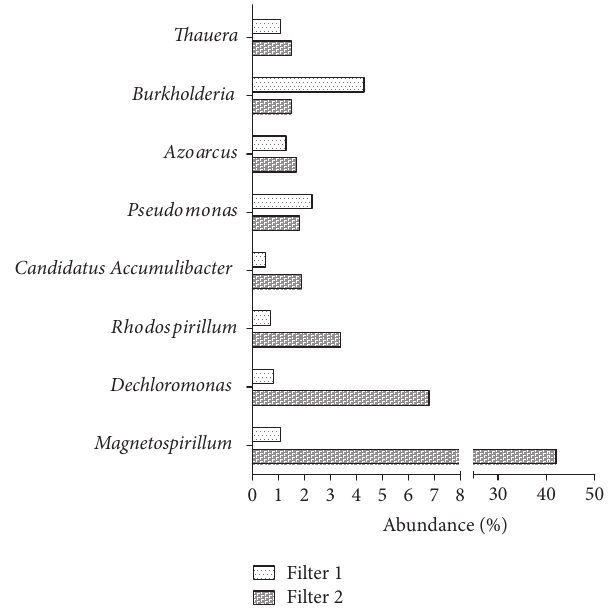
Figure 5: The most abundant genera on filter 2 compared to the abundance of the same on filter